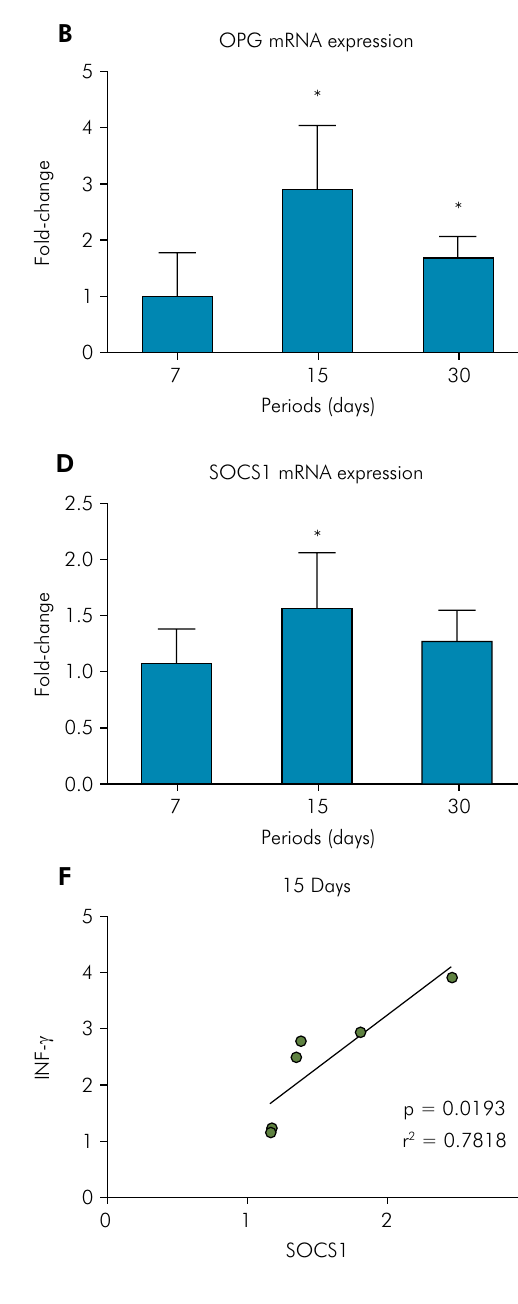
7 Braz. Oral Res.